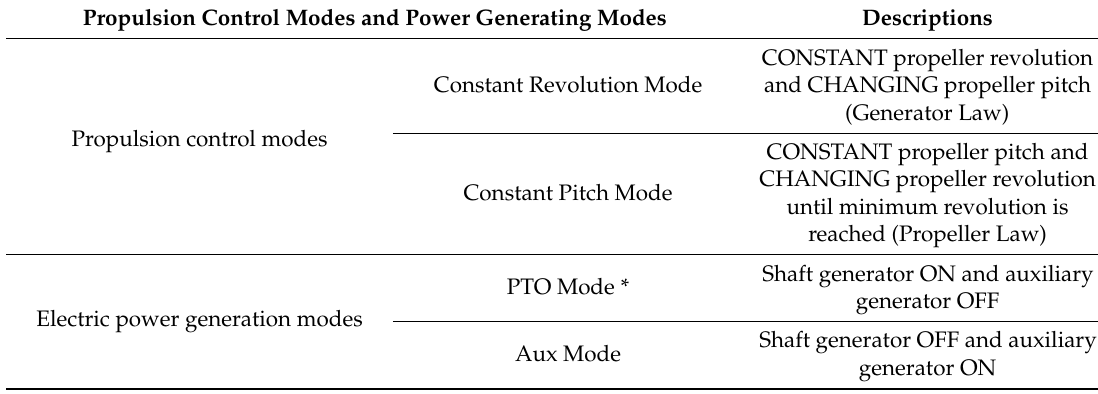
Table 5. Ship propulsion control modes and power generating